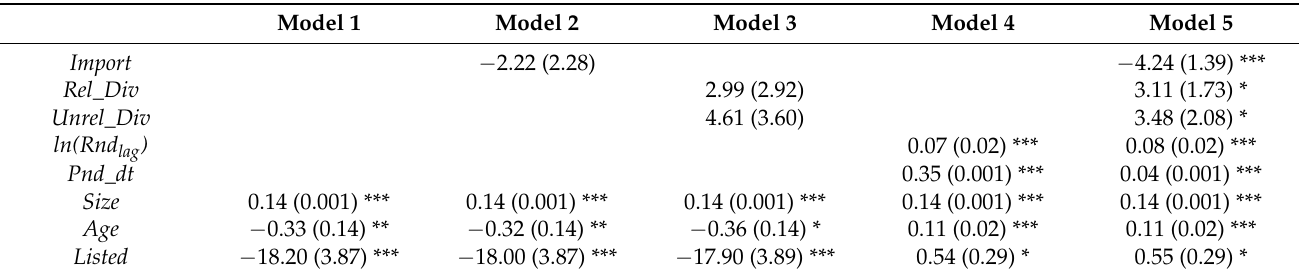
Table 5. Regression